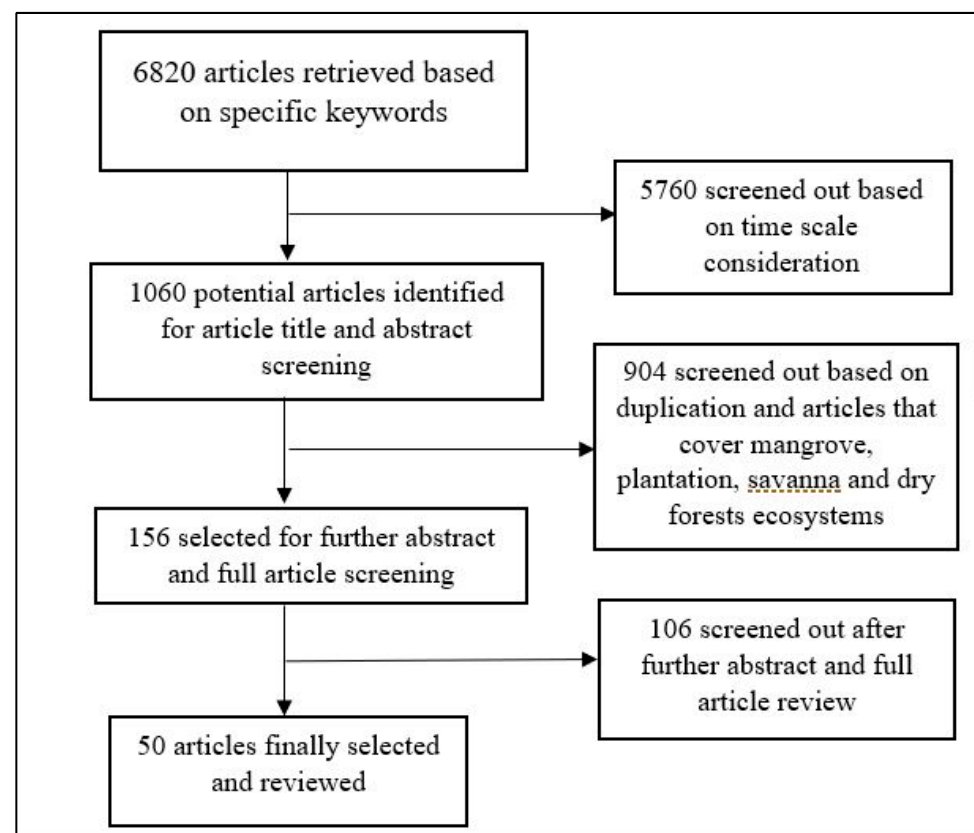
Figure 1. Schematic diagram of the selection process.